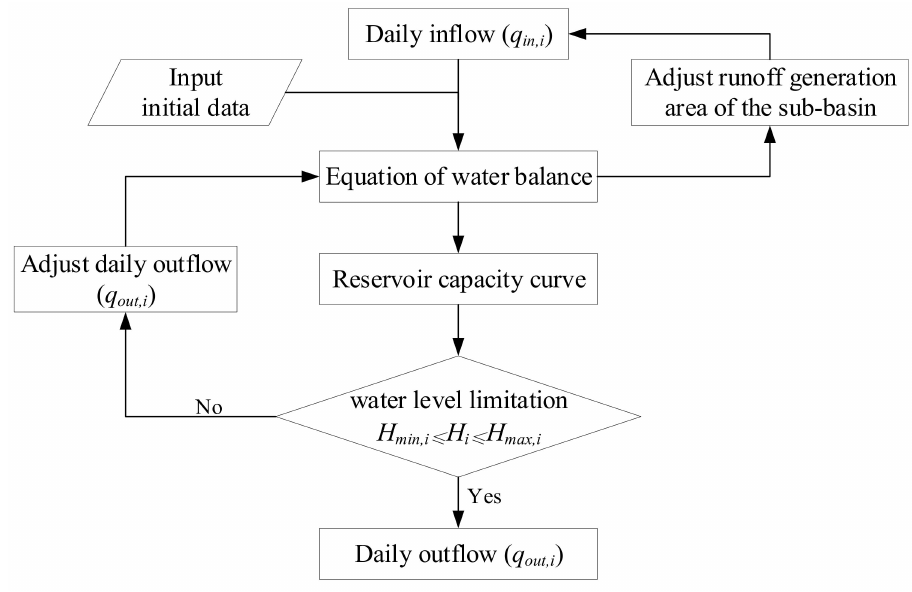
Figure 2. Reservoir calculation module